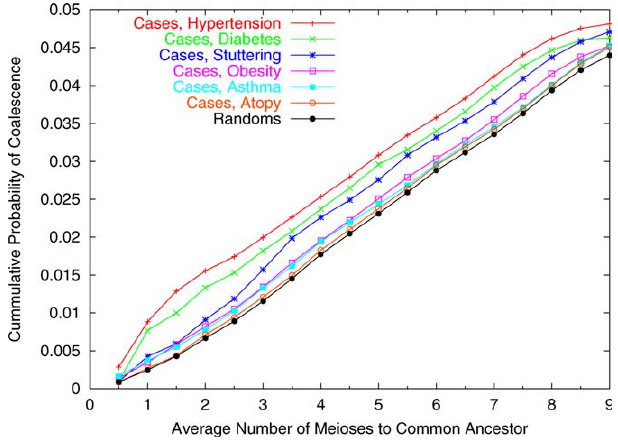
Figure 2. Cumulative Probability of Coalescence within the Last n Meioses in the Hutterite Founder Population Each line plots the estimated probability that two chromosomes drawn at random, from different individuals affected with a given phenotype, or from two random control individuals, descend from a single ancestral chromosome within the last n meioses. These estimates are based on the recorded Hutterite genealogy. The x -axis plots the average number of meioses along the two lineages back to the common ancestor. Notice that in the most recent generations, the case samples coalesce at higher rates than do random controls. DOI: